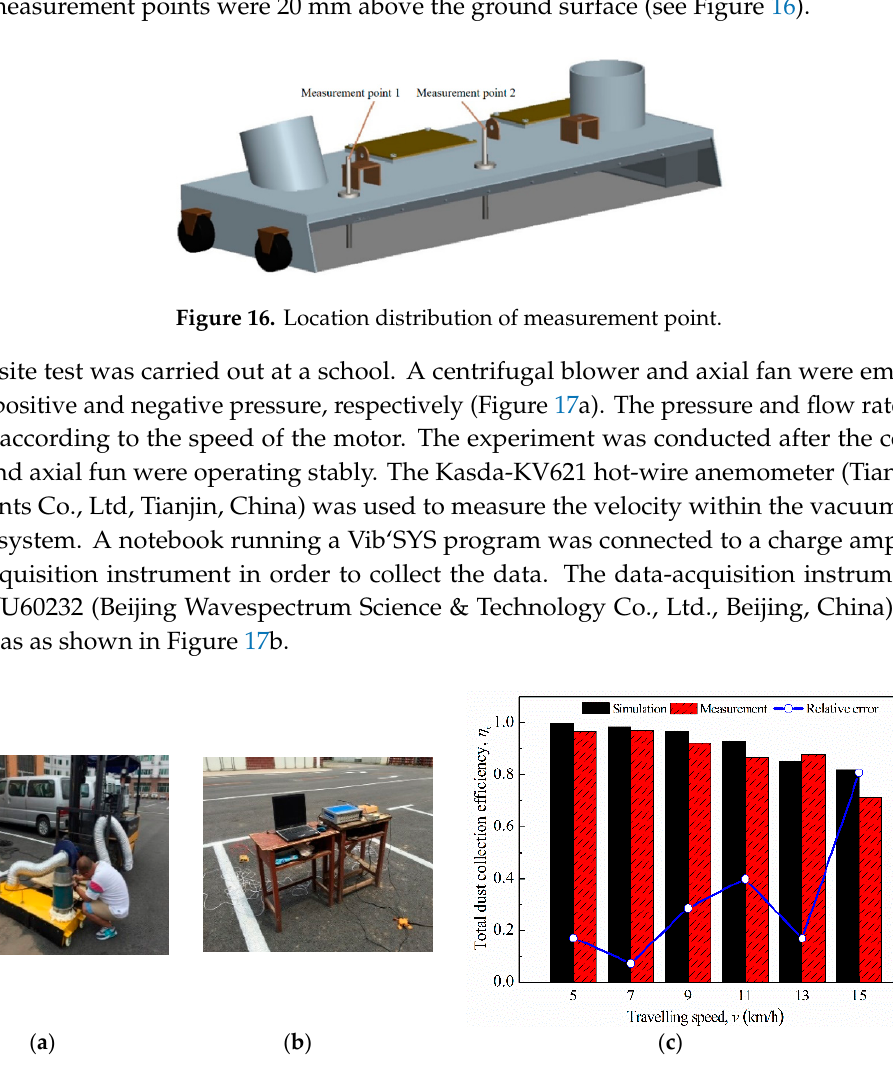
Figure 17. Site test for total dust-collection efficiency: ( a ) site test ( b ) test system ( c ) test results contrast analysis